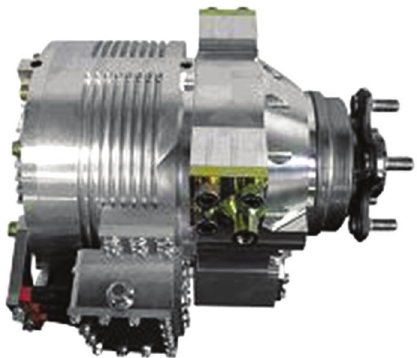
Figure 5: Motor of electric